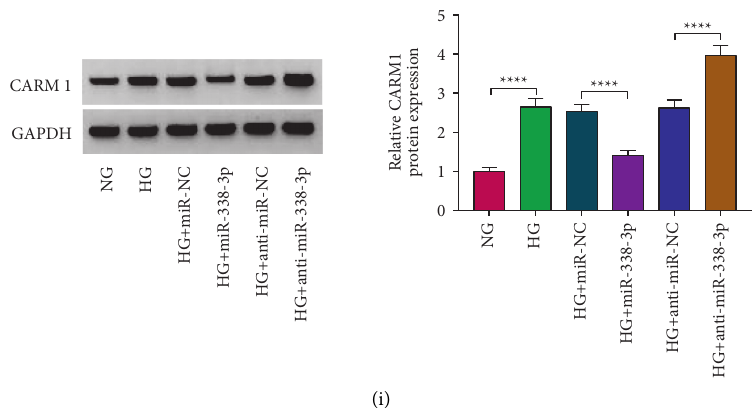
Figure 5: miR-338-3p targeted CARM1. (a) The binding sites between CARM1 3’UTR and miR-338-3p were shown. The interaction between CARM1 and miR-338-3p was verified by dual-luciferase reporter assay (b) and RIP assay (c). (d, e) The mRNA and protein expression of CARM1 in the serum of DR patients and normal control volunteers was detected by qRT-PCR and WB analysis. (f) The correlation between CARM1 and miR-338-3p was analyzed by Pearson’s correlation coefficient analysis. (g) The CARM1 protein expression in ARPE-19 cells under HG and NG conditions was determined by the WB analysis. (h) The miR-338-3p expression was detected by qRT- PCR to evaluate the transfection efficiency of miR-338-3p mimic and inhibitor. (i) The protein expression of CARM1 was detected by the WB analysis in HG-induced ARPE-19 cells transfected with miR-338-3p mimic and inhibitor. ∗∗ P < 0 . 01, ∗∗∗ P < 0 . 001, and ∗∗∗∗ P < 0 .